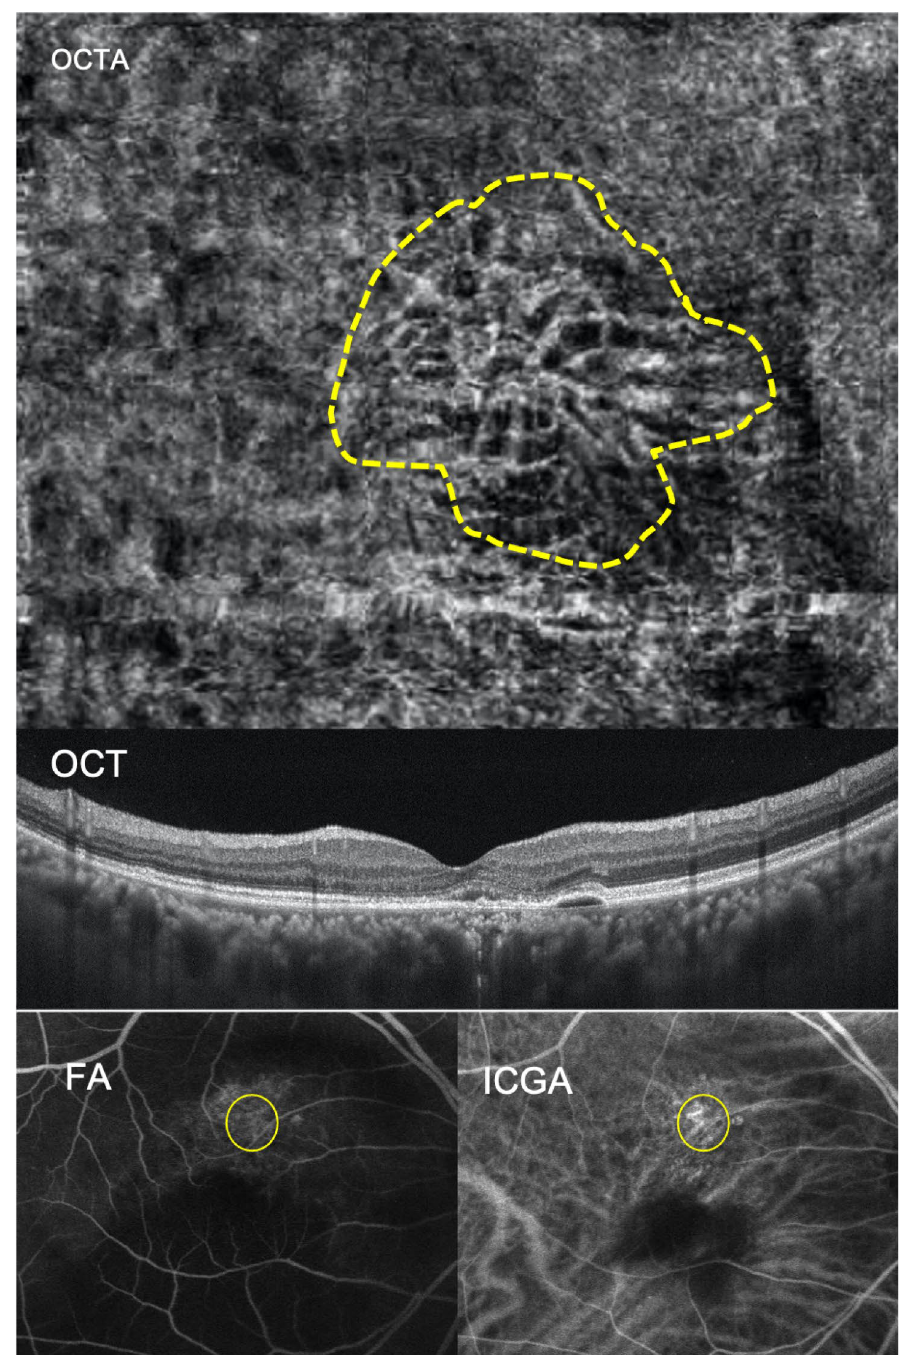
Figure 3. A 65-year-old male patient with type 3 BVN and type C BVN in the right eye. Baseline BCVA was 20/80. The OCTA image retrieved by AngioVue (RTVue XR Avanti, Optovue Inc., Fremont, CA, USA) disclosed small, tangled calibre of choroidal vessel without significant anastomoses (stick form, highlighted by dashed line) and perifoveal RPED with some subretinal fluid. The SFCT was approximately 350 μm. FA and ICGA images showed an intercollecting vessel without an obvious feeding origin (circle). BVN branching vascular network, PCV polypoidal choroidal vasculopathy, BCVA best-corrected visual acuity, FA fluorescent angiography, ICGA indocyanine green angiography, OCTA optical coherence tomography angiography, RPED retinal pigment epithelial detachment, SFCT subfoveal choroidal